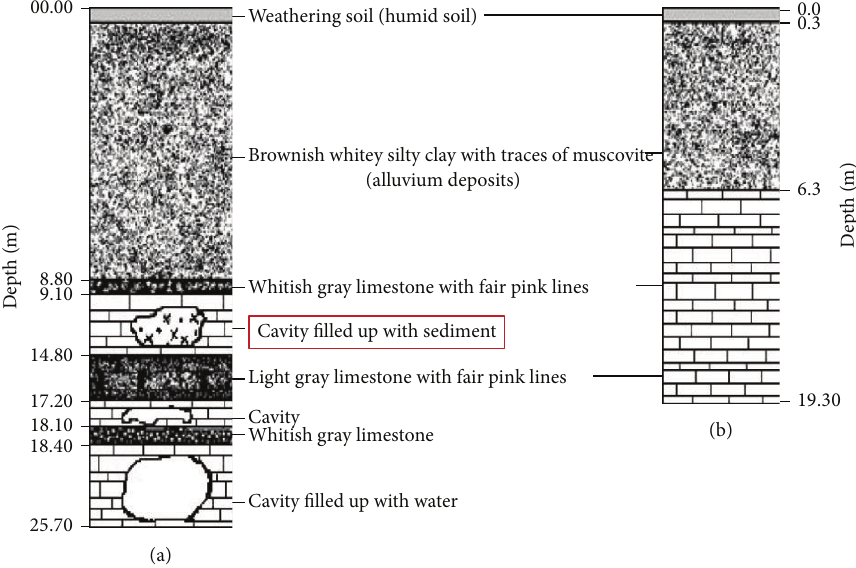
Figure 12: Borehole information in Batu Cave adopted from [20].